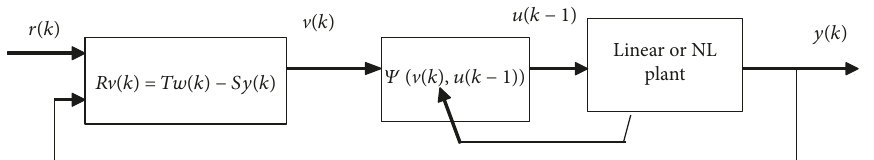
Figure 4: Structured UPPC control system.